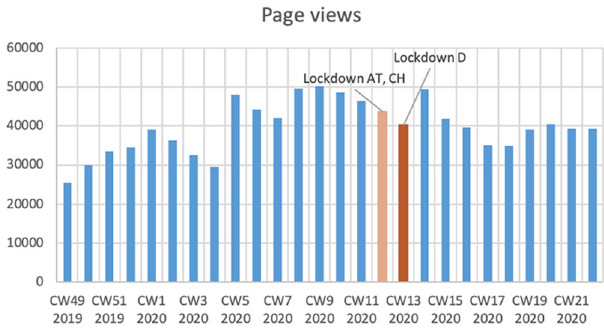
Fig. 2 Course of the session duration over time (average per week). A more or less constant duration can be seen, that is not substantially in fl uenced by the lockdown (Austria (AT), Switzerland (CH) = pink; Germany (D) = orange). CW = Calendar week.